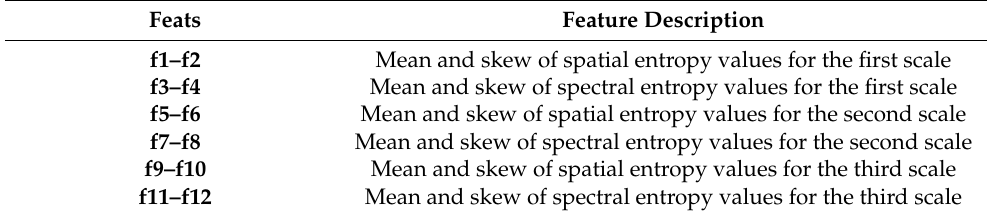
Table 3. Extracted features based on